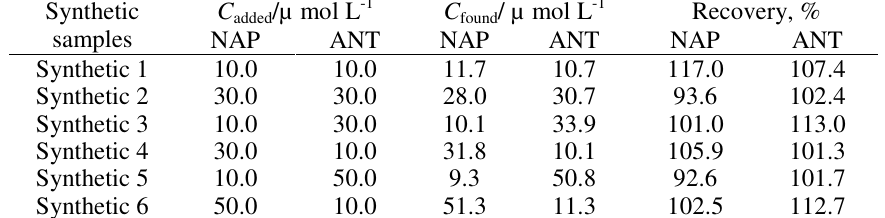
Table 1. Determination of naphazoline and antazoline in some synthetic mixtures